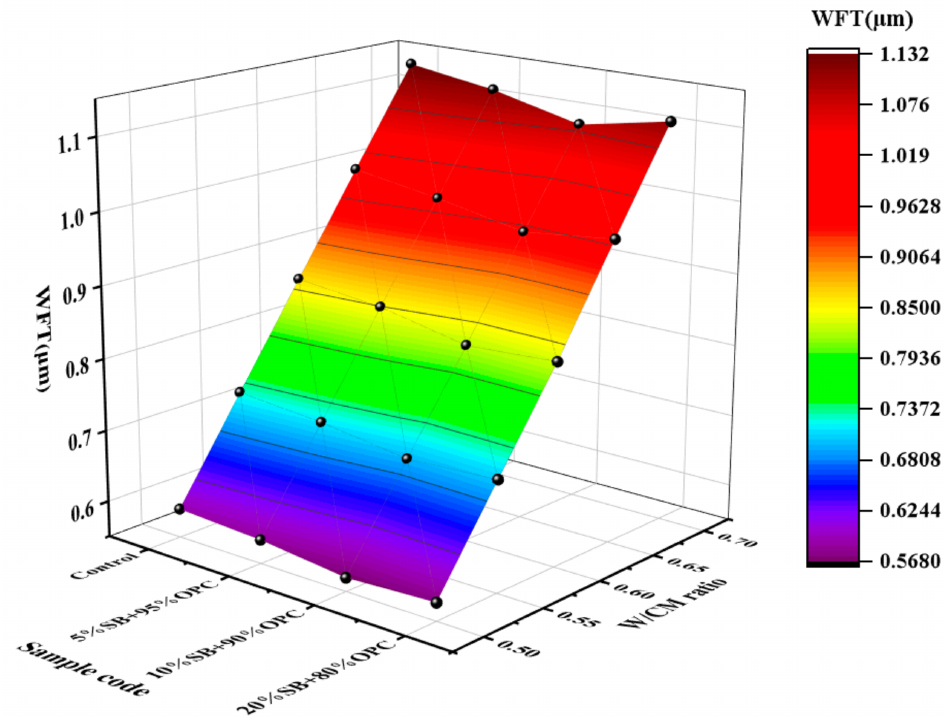
Figure 4. Variations of the WFT with W/CM ratio at different SB